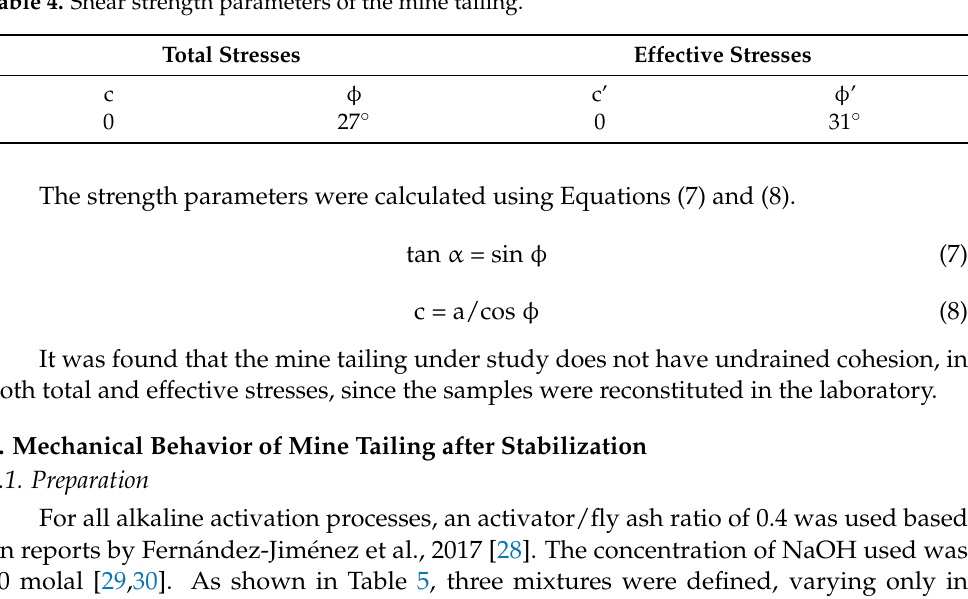
Table 4. Shear strength parameters of the mine tailing.